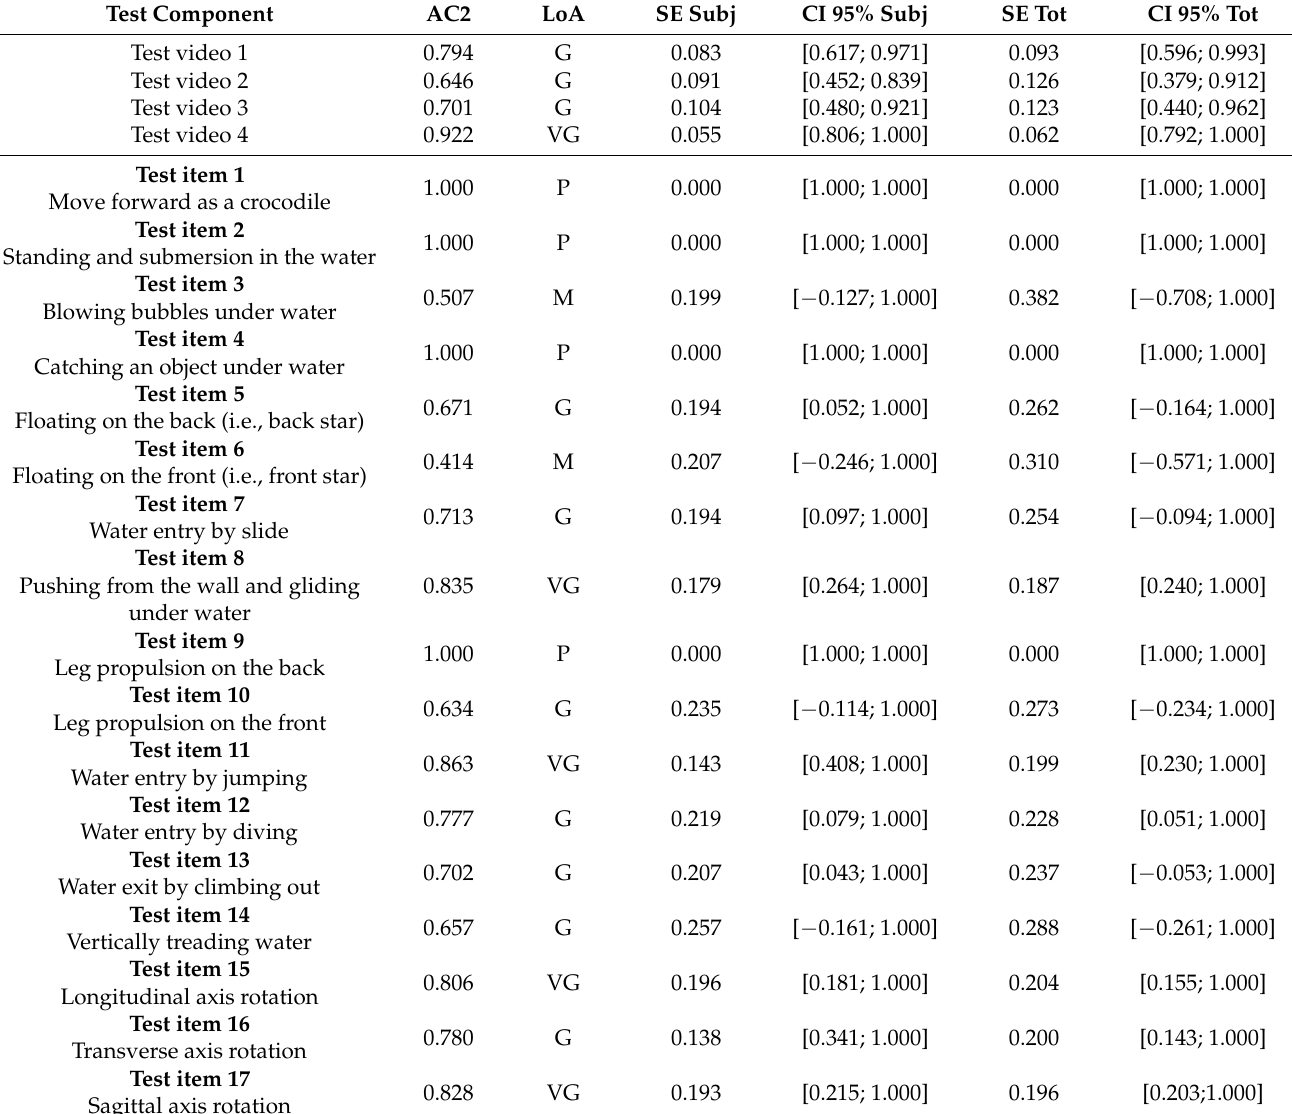
Table 4. Gwet’s AC2 test results for inter-rater reliability.